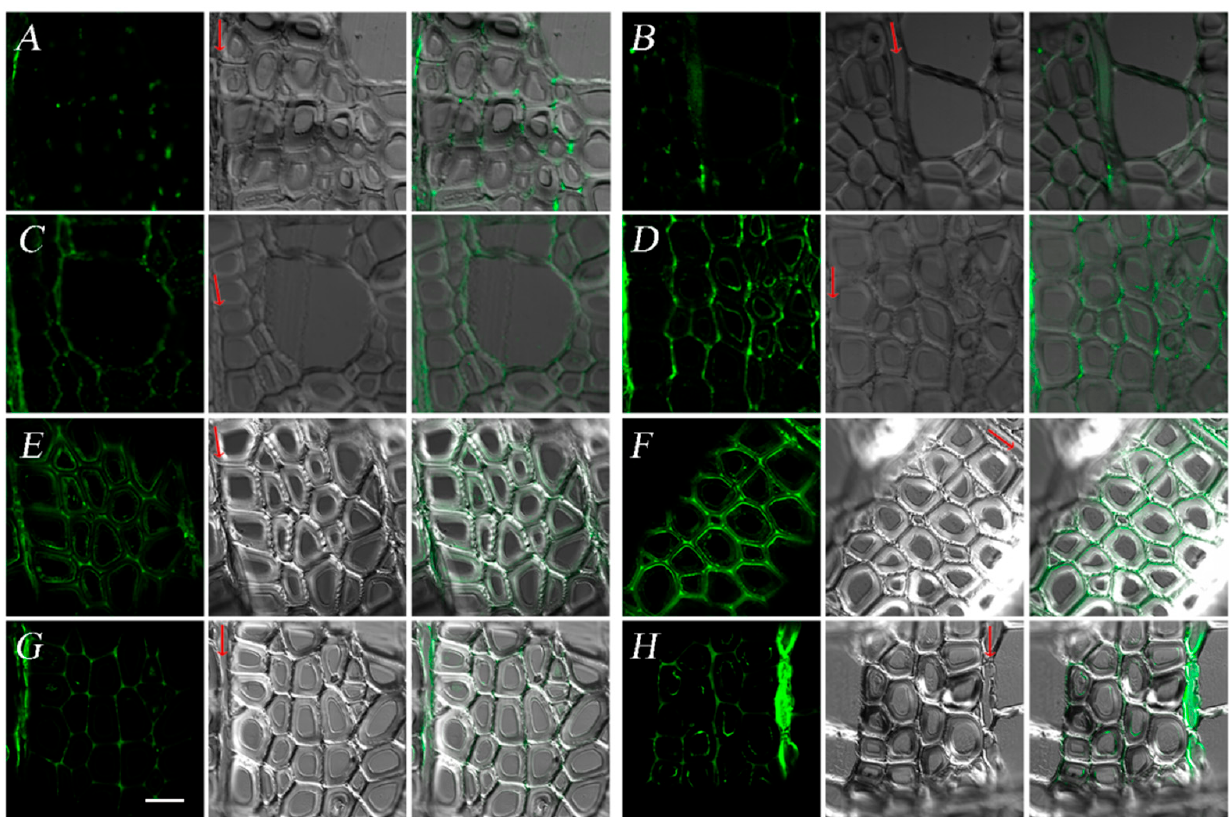
Figure 6. Pectin immune localization in mature xylem of P. euramericana ‘Zhonglin46’ ( A , C , E , G ) and P. euramericana ‘Neva’ ( B , D , F , H ). ( A , B ) JIM5-labeled unesterified pectin. ( C , D ) JIM7-labeled esterified pectin. ( E , F ) LM5-labeled RG-I pectin. ( G , H ) LM6-labeled RG-I pectin. The red arrowhead indicates the direction of the radial wall. Scale bar = 20 µm.